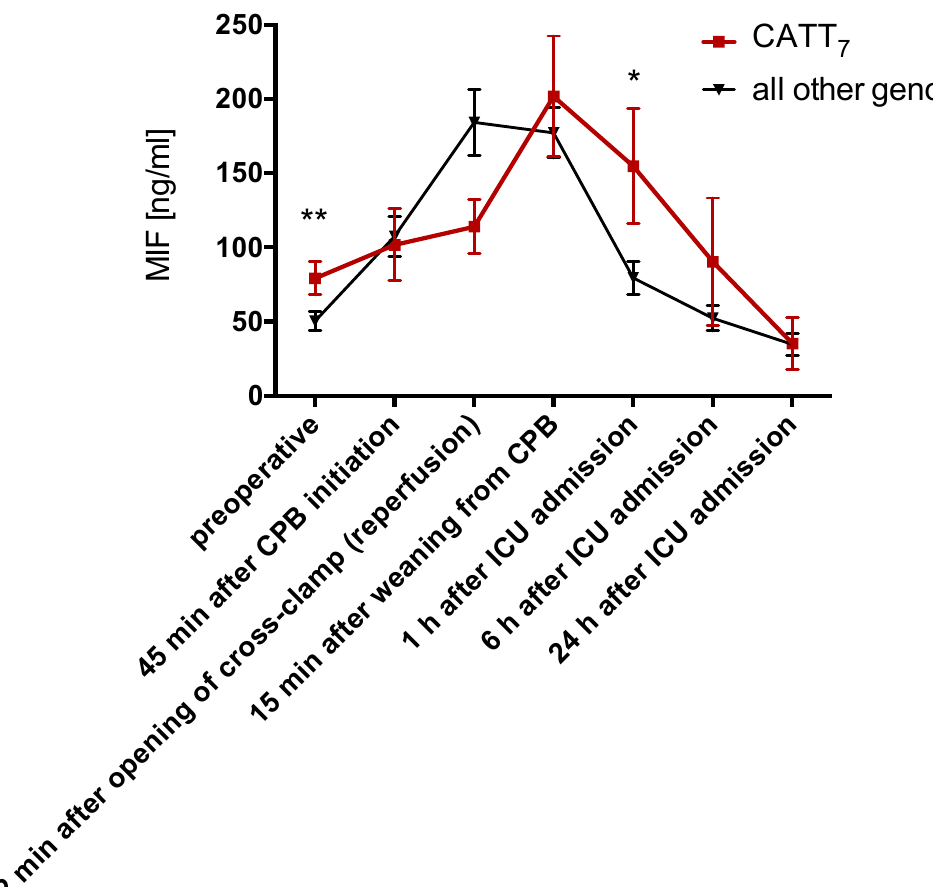
Figure 3. Perioperative kinetics of serum MIF in patients undergoing cardiac surgery. * P < 0.05, ** P < 0.01. Serum MIF was quantified with ELISA in 100 patients. Patients heterozygous or homozygous for the MIF CATT 7 allele had significantly increased serum MIF before surgery (preoperative) and significantly lower serum MIF 1 h after surgery. Data are means ± SEM. ** p < 0.01, * p < 0.05